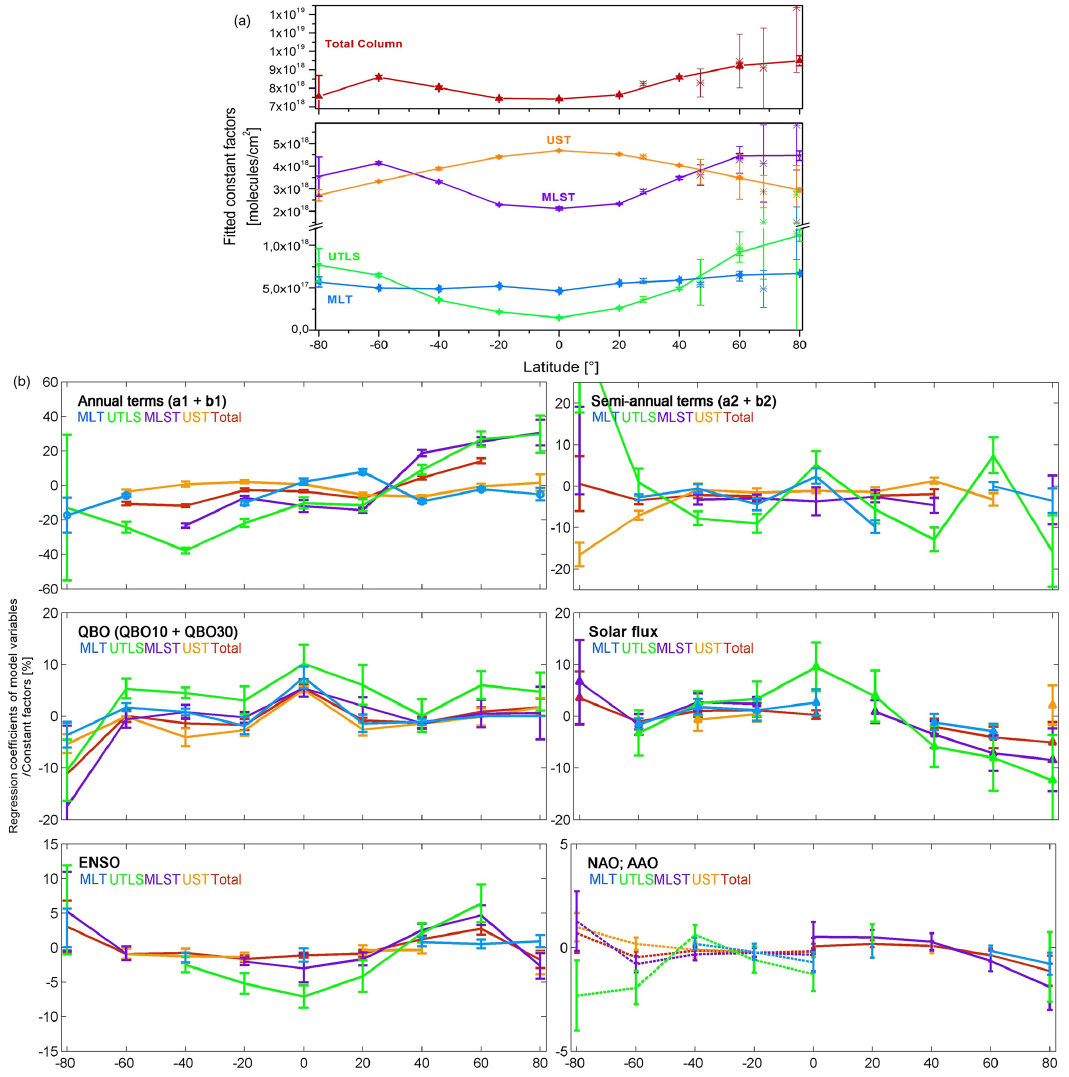
Figure 8. (a) Fitted constant factors (Cst; see Eq. 1, Sect. 3) from the 6-year IASI daily O 3 time series for the 20 ◦ latitude belts, separately given for the four layers and for the total column. The stars correspond to the constant factors fitted above ground-based measurement stations: Ny-Ålesund (79 ◦ N), Kiruna (68 ◦ N), Harestua (60 ◦ N), Jungfraujoch (47 ◦ N) and Izana (28 ◦ N). (b) Regression coefficients of the variables retained by the stepwise procedure, given in % as (cid:2) regression_coefficient / fitted_cst (cid:3) × 100%. Identification for the variables: annual (top left) and semi-annual variation (top right) terms, QBO at 10 and 30hPa (bottom left) and solar flux (bottom right). Note that the scales are different. The associated fitting uncertainties (95% confidence limits) are also represented (error